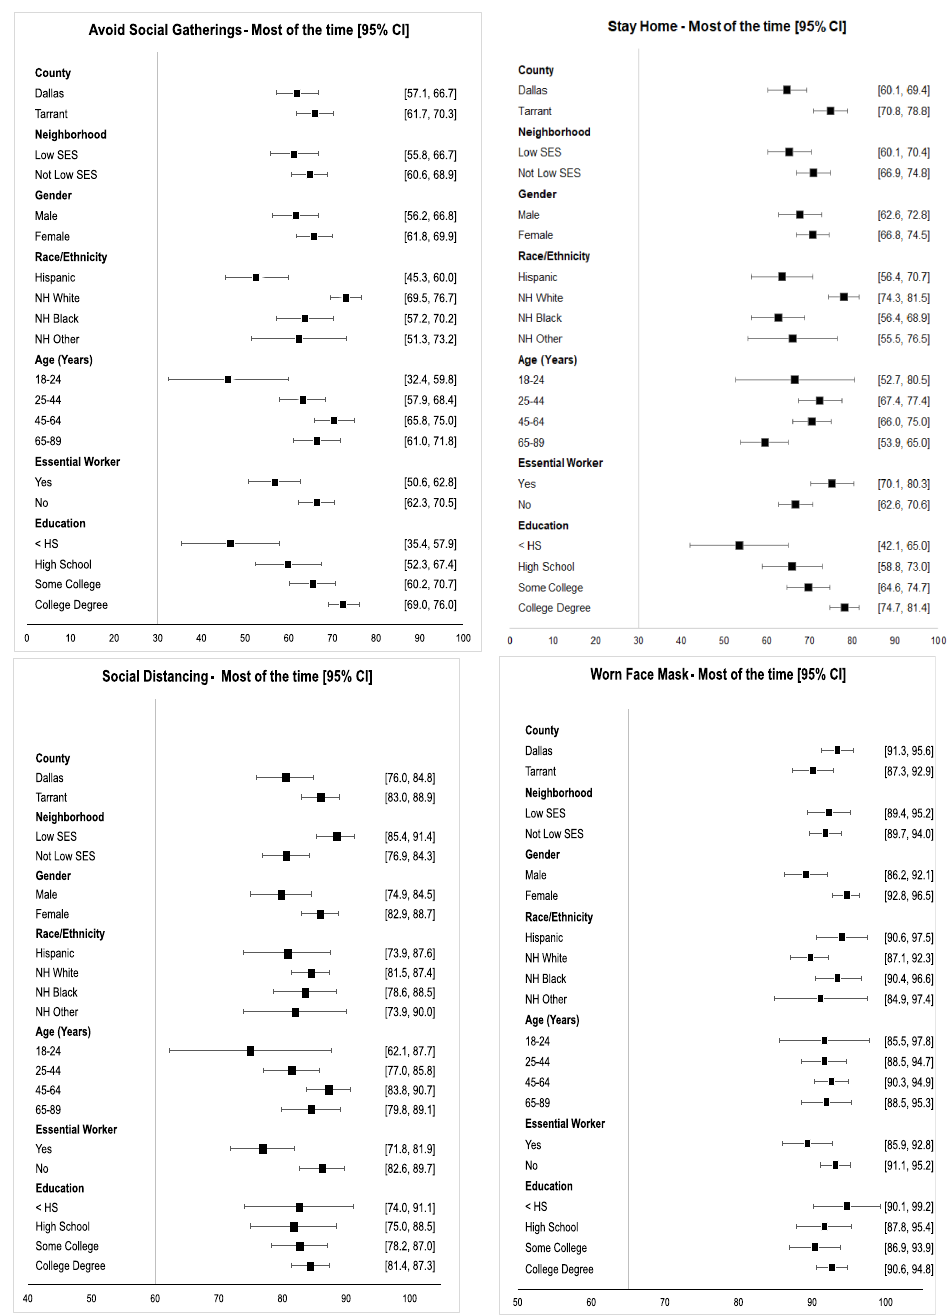
Fig 2. Estimated prevalence by select behaviors that lower risk of COVID-19 infection. SES = Socioeconomic status. Non-Hispanic (NH) Other is comprised of racial groups other than White and Black including multiracial. Essential workers (Yes) are defined as those who worked onsite in the past 30 days at the time of the survey most of the time and who came into frequent contact with the public. The ‘No” category includes those not working (e.g., student, retired). Education: < HS = less than high school/ high school no diploma; HS = high school, vocational, business or trade school; some college = some college no degree/associate degree; college degree = 4-year college/university degree/ graduate school.